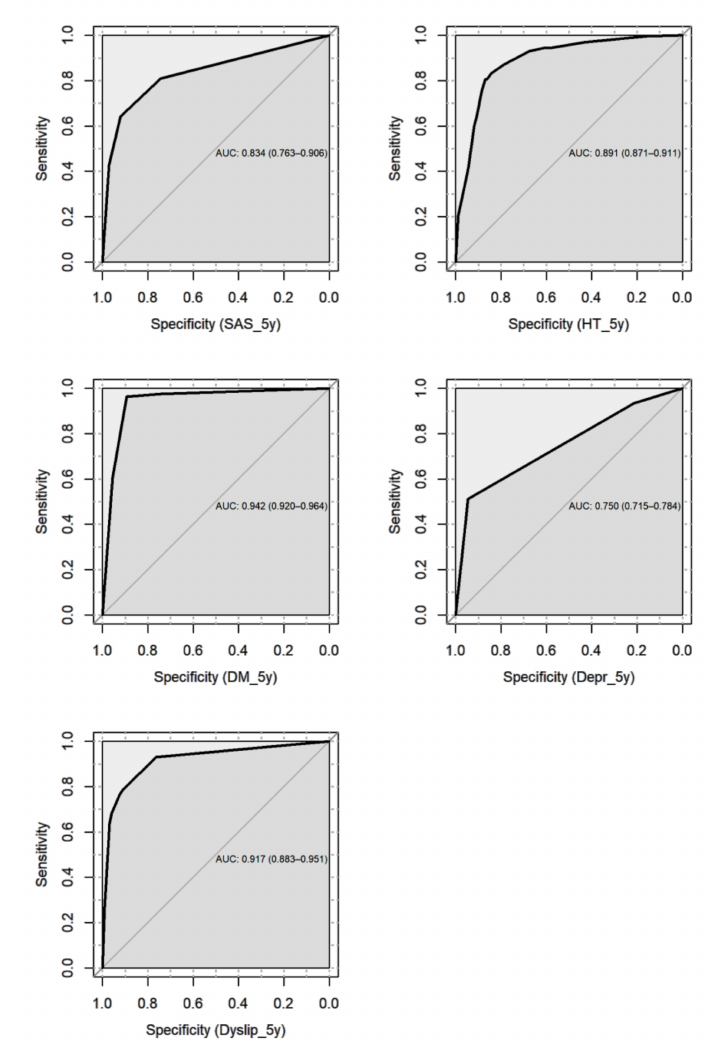
Figure 3. Receiver operating characteristic (ROC) curve of the discrete Bayesian network (DBN) for predicting 5-year comorbidity after bariatric surgery.